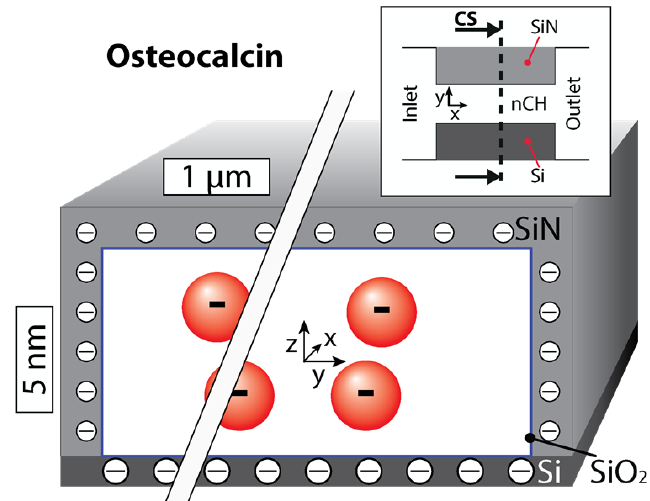
Figure 4. Cross-section of a nanochannel qualitatively showing the distribution of a 5 nm nanochannel. Please note that the aspect ratio was lessened for better visual representation of the molecular distribution.